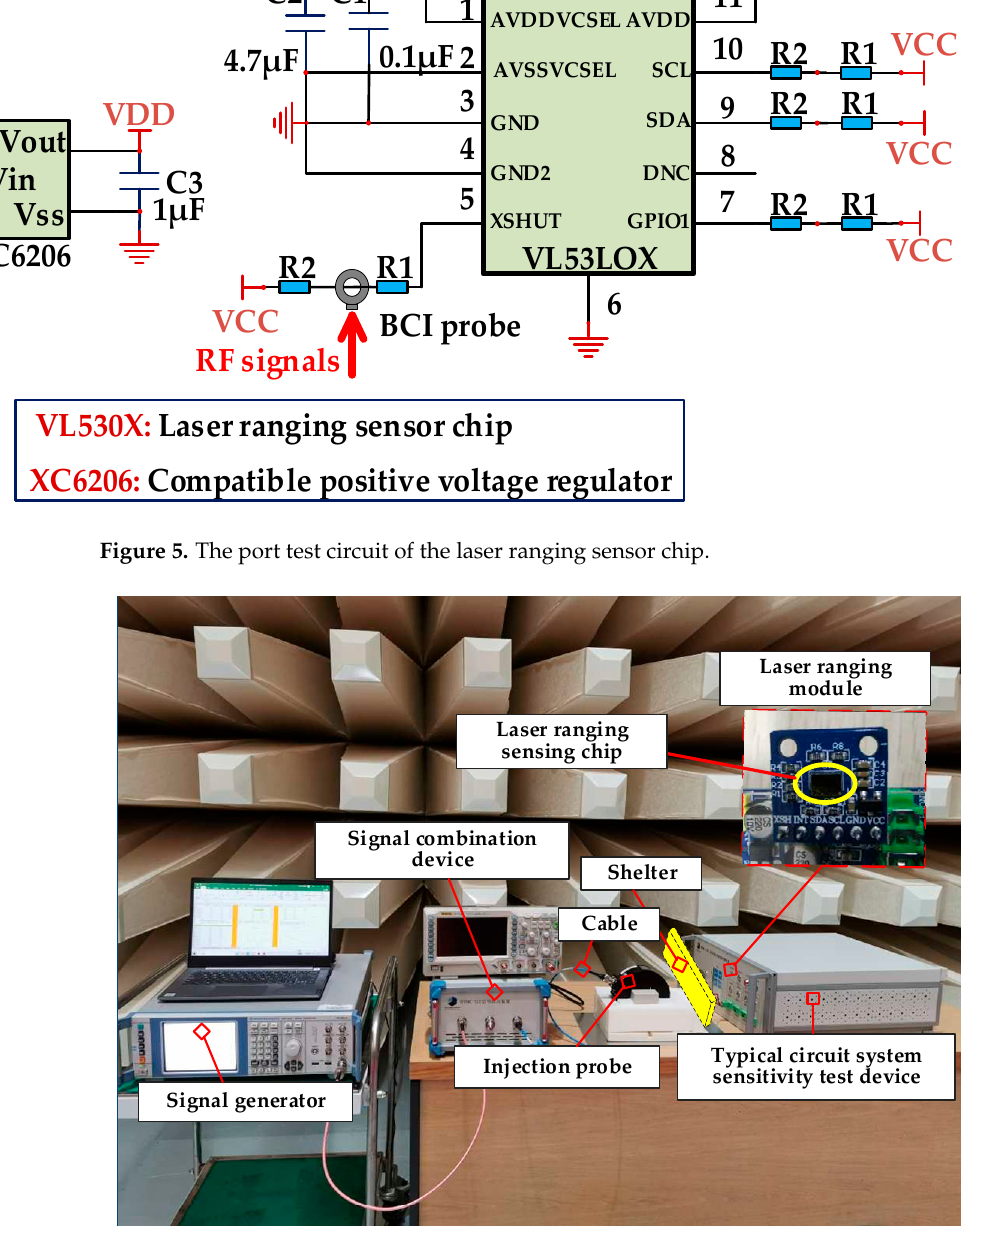
Figure 6. The electromagnetic sensitivity test platform of the laser ranging system.